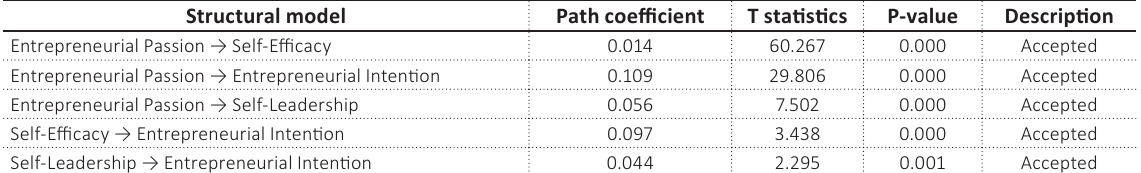
Table 3. Research hypotheses testing